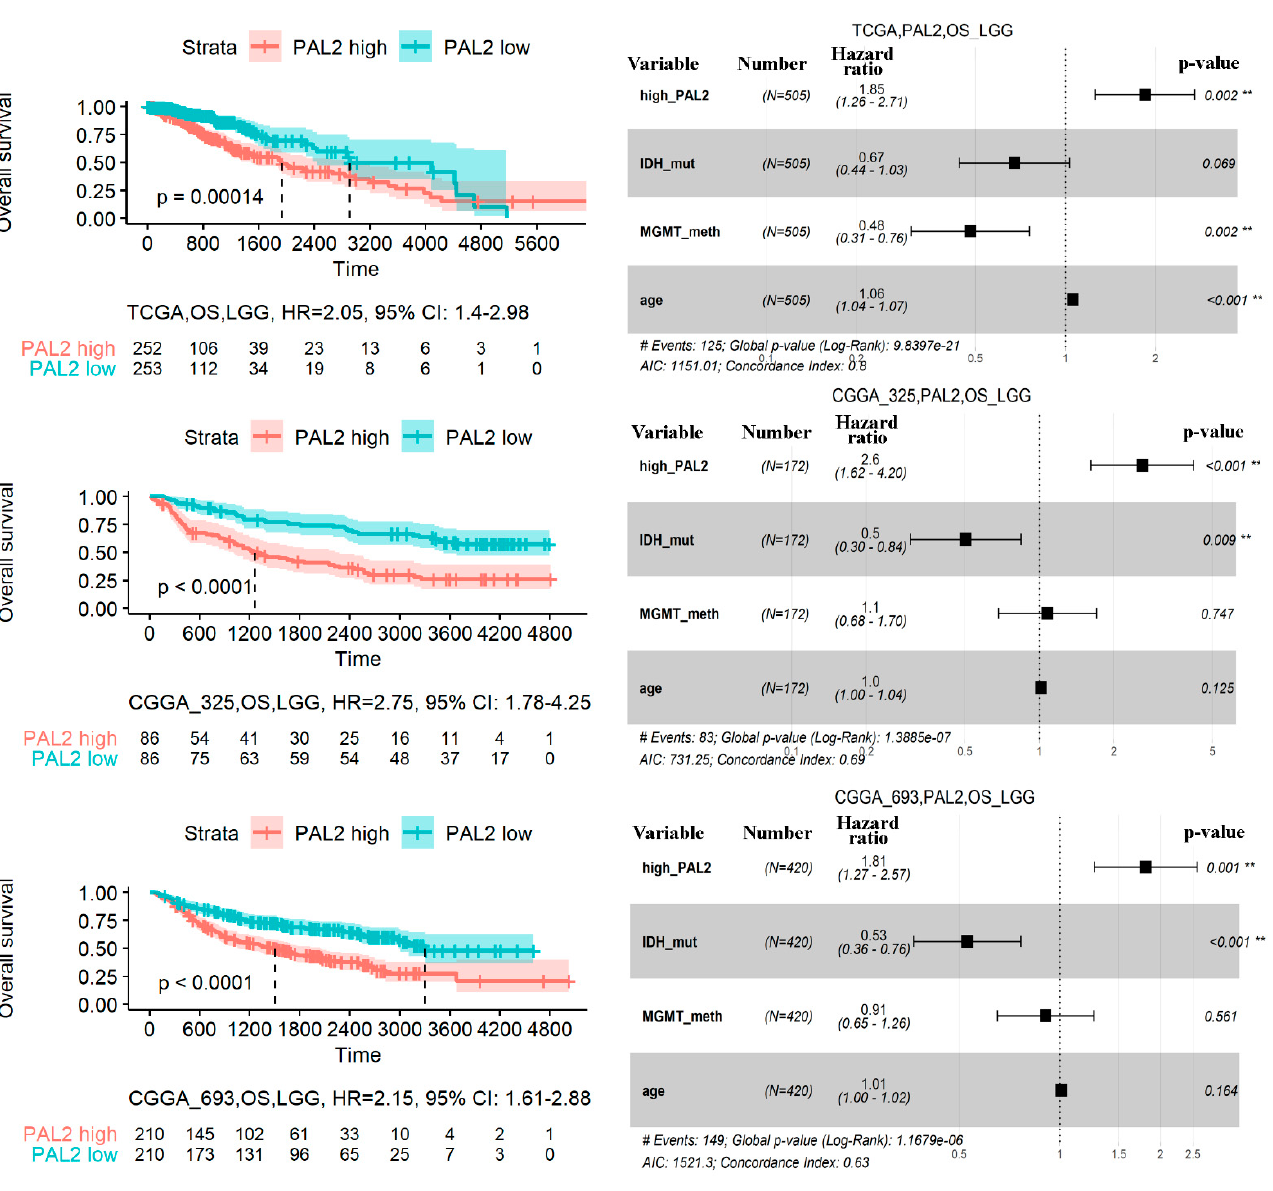
Figure 6. Kaplan-Meyer, univariate and multivariate Cox analyses of OS in LGG for three literature datasets (TCGA, CGGA_325, and CGGA_693). The samples were grouped by PAL2 level relatively to PAL2 median value (“high” PAL2: PAL2 > median(PAL2); “low” PAL2: PAL2 < median(PAL2)). Time is given in days in all graphs. ** stands for p < 0.01